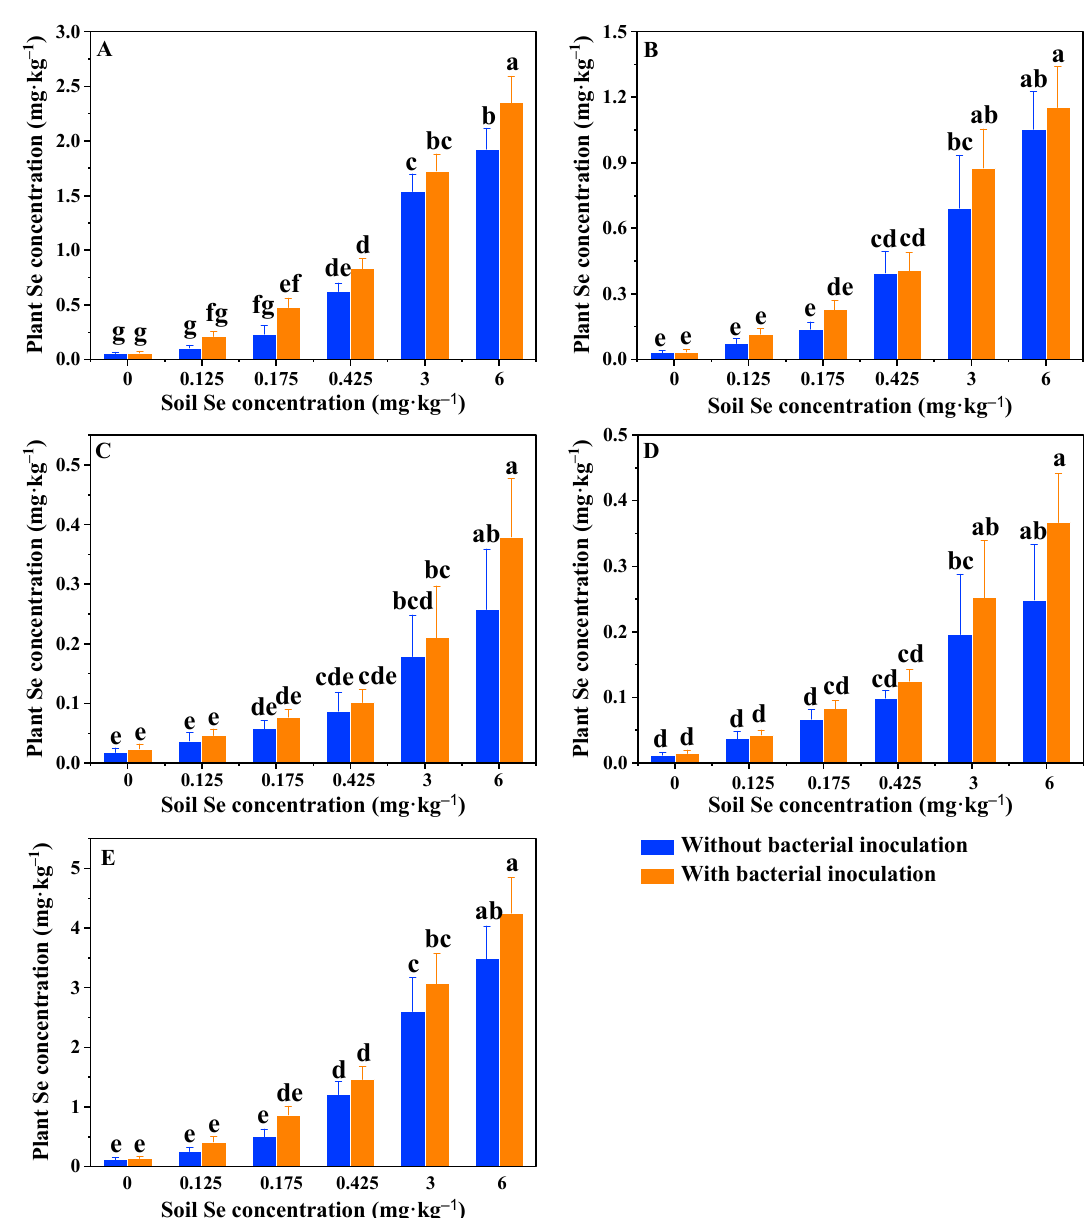
Figure 5. Se concentrations in the root biomass ( A ), husk biomass ( B ), leaf biomass ( C ), grain biomass ( D ) and total biomass ( E ) of rice plants with or without the inoculation of strain LWS1 ( n = 4). The plants were grown in the soils spiked with 0–6 mg·kg –1 SeIV. Different letters indicate significant differences between treatments based on two-way ANOVA by Tukey's multiple comparisons test at p ≤ 0.05.